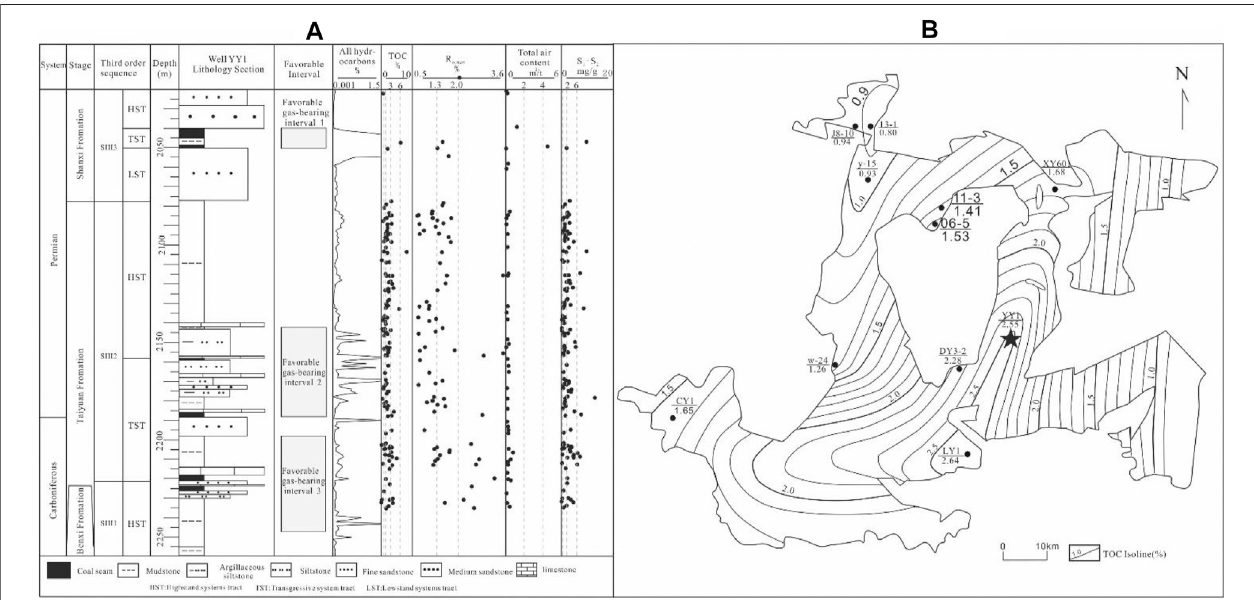
FIGURE 5 | TOC features of the Shanxi and Taiyuan Formations shale.